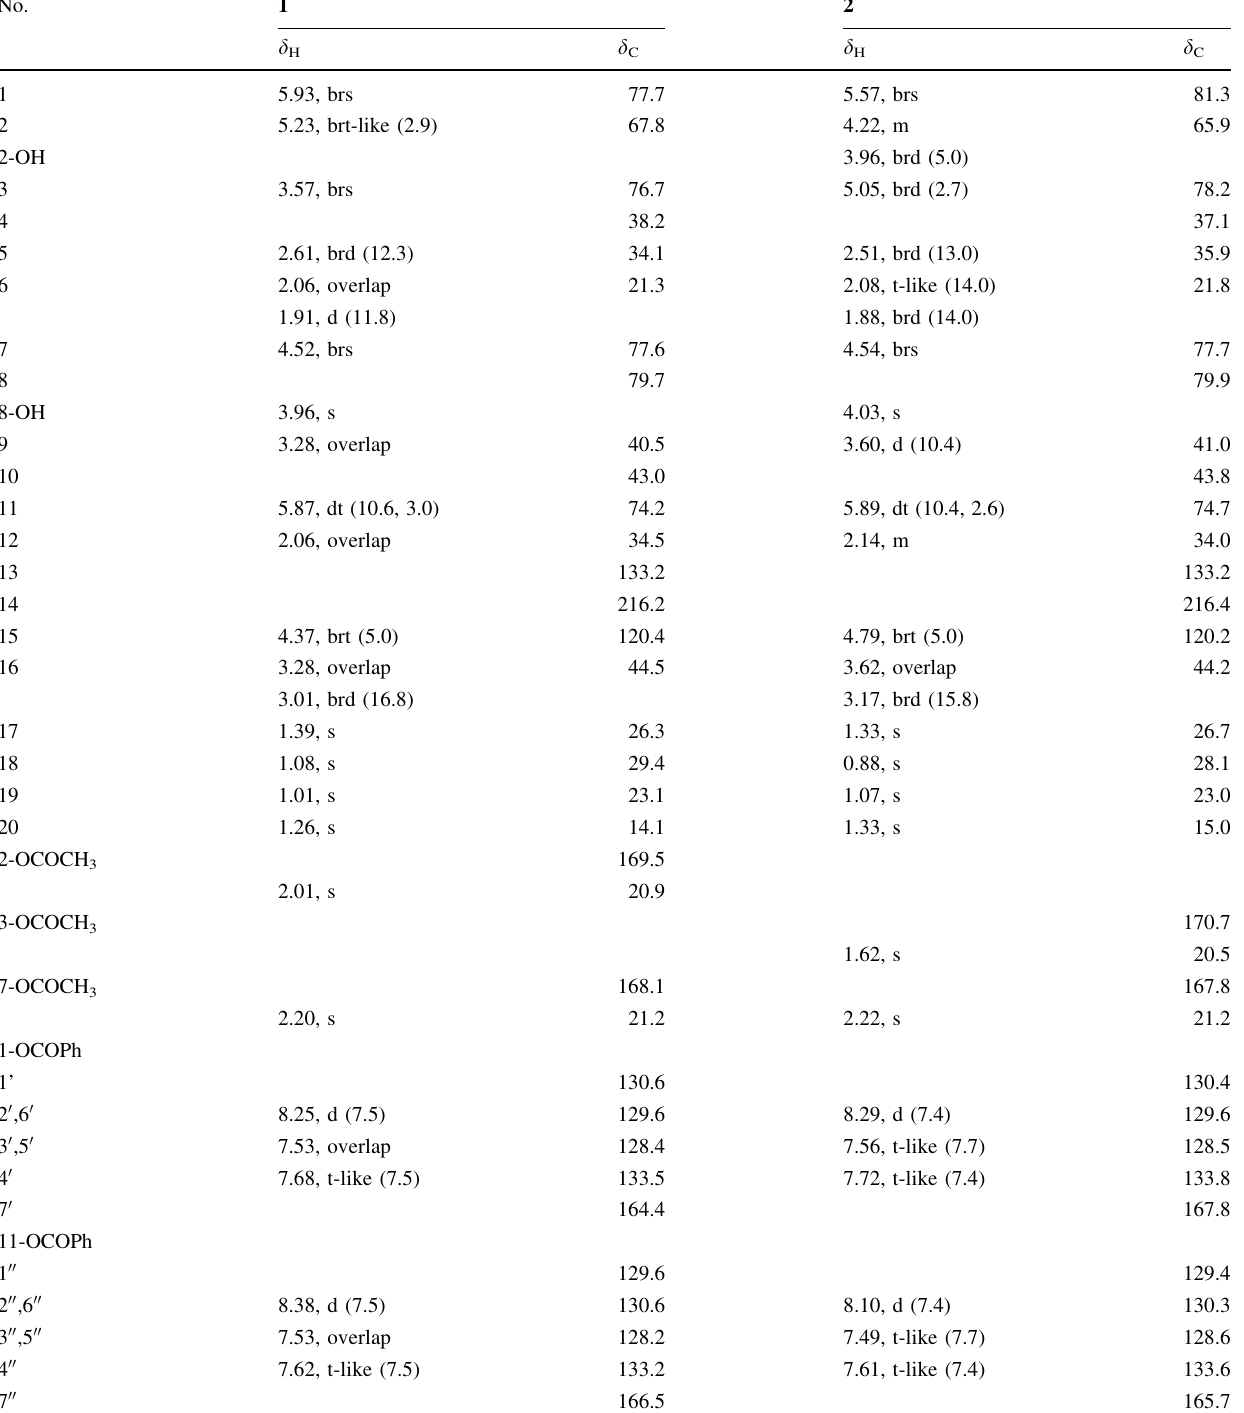
Table 1 1 H and 13 C NMR spectral data (600 MHz for 1 H and 150 MHz for 13 C in CDCl 3 ) of compounds 1 and 2 ( d in ppm, J in Hz)